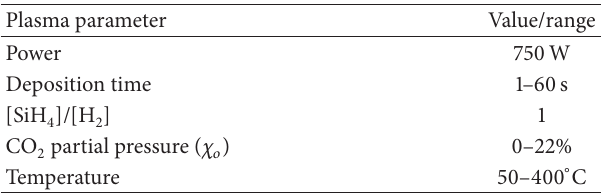
Table 1: Plasma parameter variation used in this